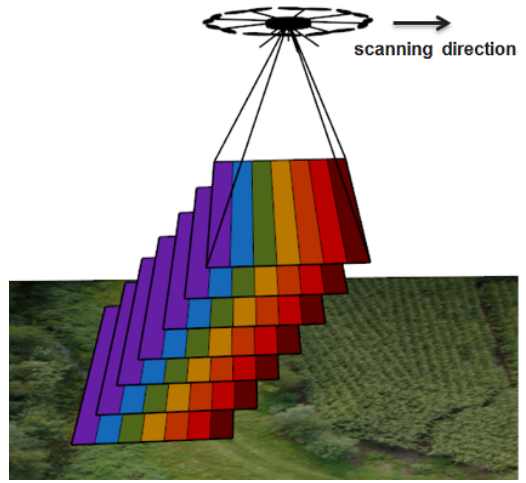
Figure 2. Principle of data acquisition with LVF based imagers.